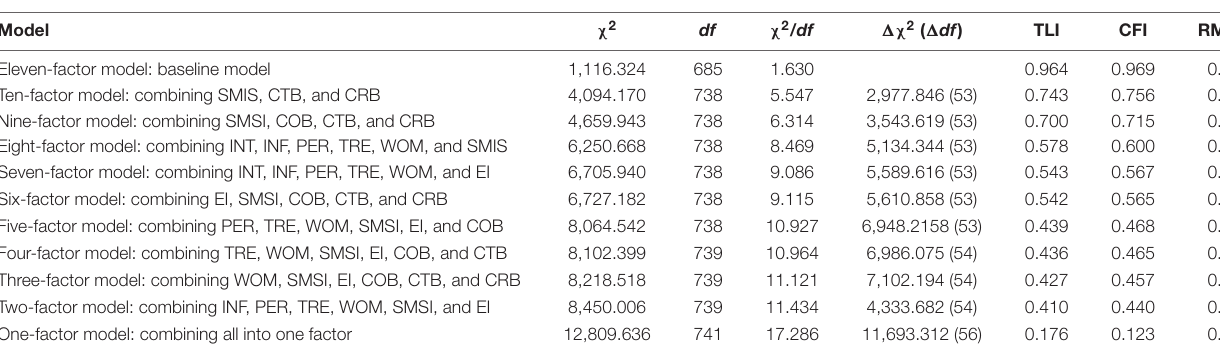
TABLE 2 | Confirmatory factor analysis.